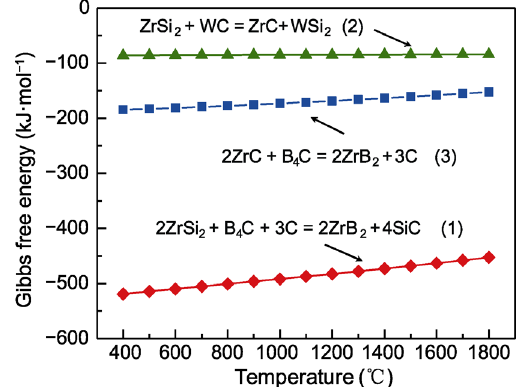
Fig. 3 Gibbs free energy of different reactions as a function of temperature.